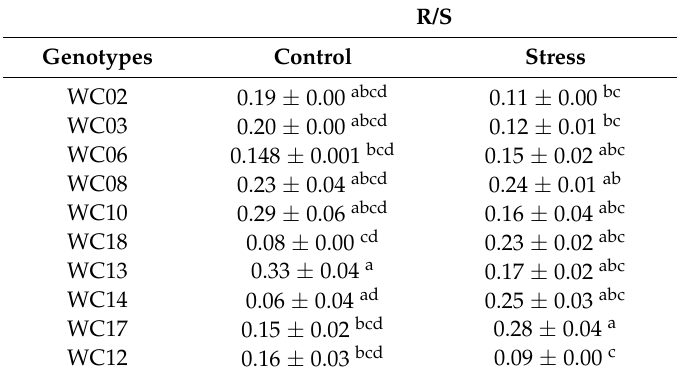
Table 4. Root to Shoot Ratio (R/S) of the Ten Genotypes Under Normal and Water Deficit Conditions.